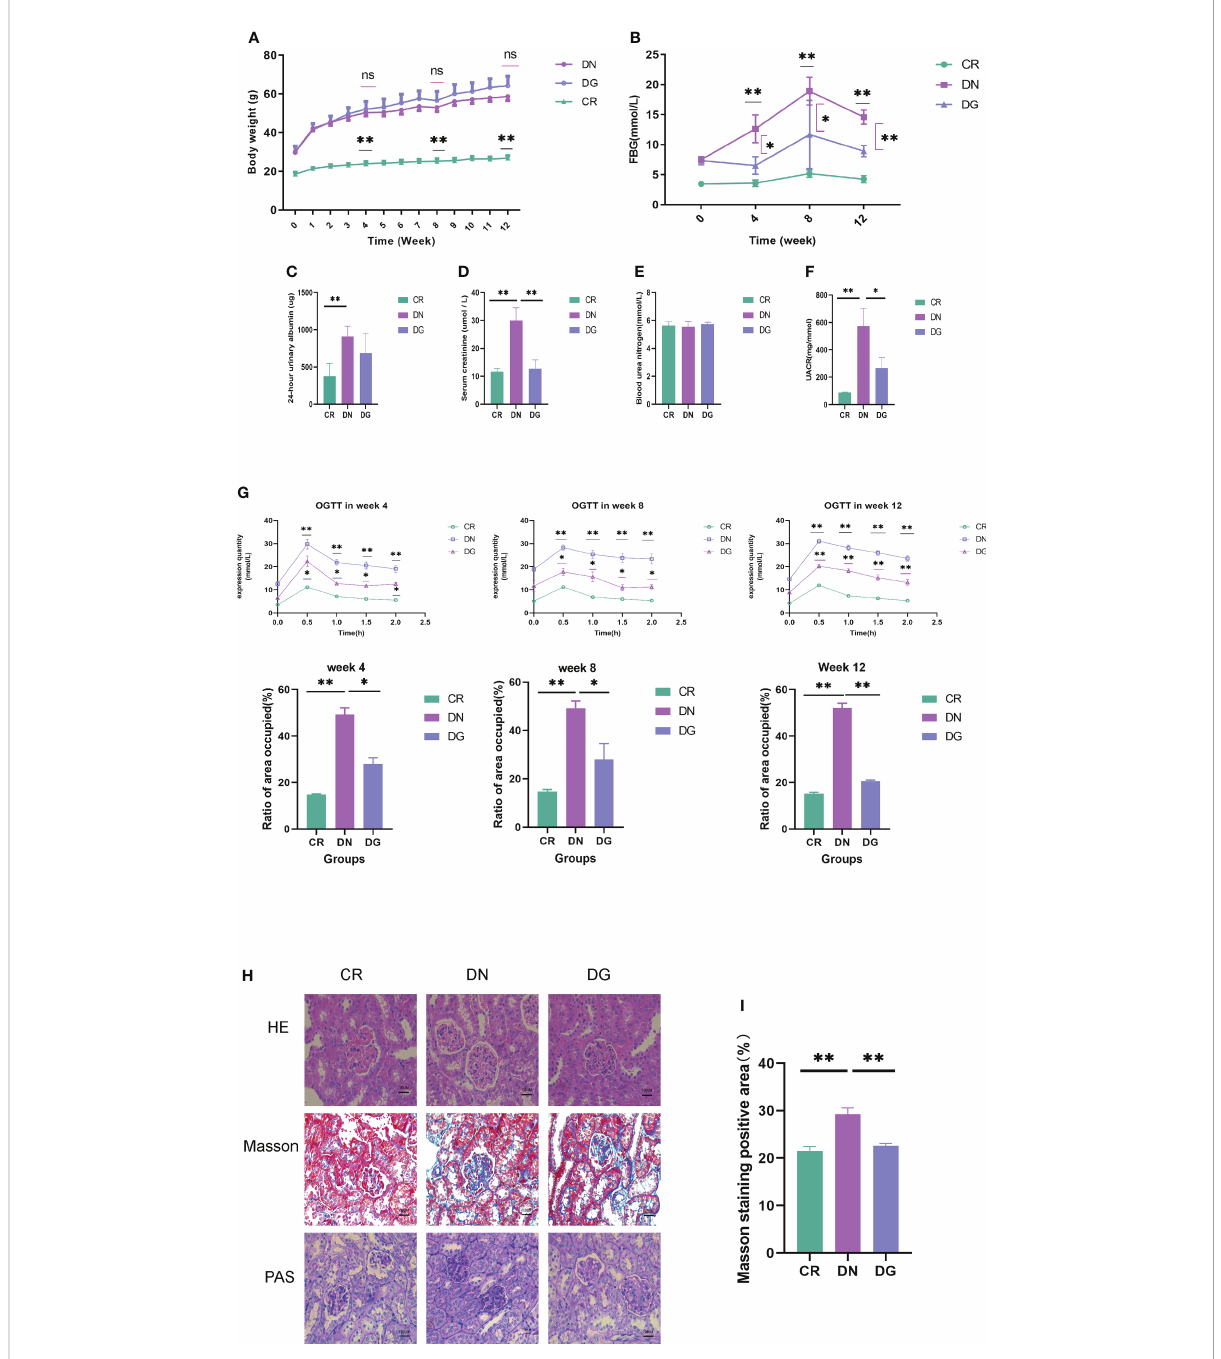
FIGURE 1 Dapagli fl ozin improved kidney injury in db/db mice. (A) The body weights recorded every week (n=6). (B) Quantitative analysis of fasting blood glucose (FBG) (n=6). (C) Quantitative analysis of 24-hour urinary albuamin (n=4-5). (D) Quantitative analysis of serum creatinine (SCR) (n=5). (E) Quantitative analysis of blood urea nitrogen (BUN) (n=5). (F) Quantitative analysis of urinary albumin/creatinine ratio (UACR) (n=4). (G) The levels of OGTT and AUC at week4, week8 and week12 (n=6). (H-I) The pathologic changes in kidneys via HE, PAS and Masson staining. Data are presented as the mean ± SE. *P < 0.05; **P < 0.001. AUC, Area under the curve; CR, control group; DN, diabetic nephropathy group; DG, dapagli fl ozin group; OGTT, Oral glucose tolerance test. ns, no signi fi